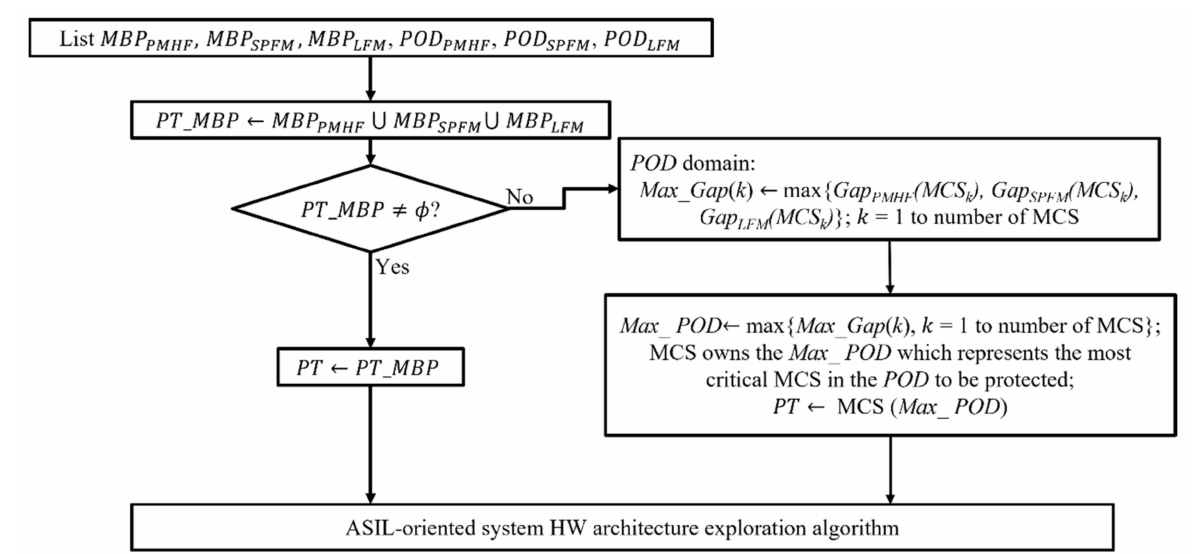
Figure 3. Execution flow of the proposed FTA-based weak-point analysis.